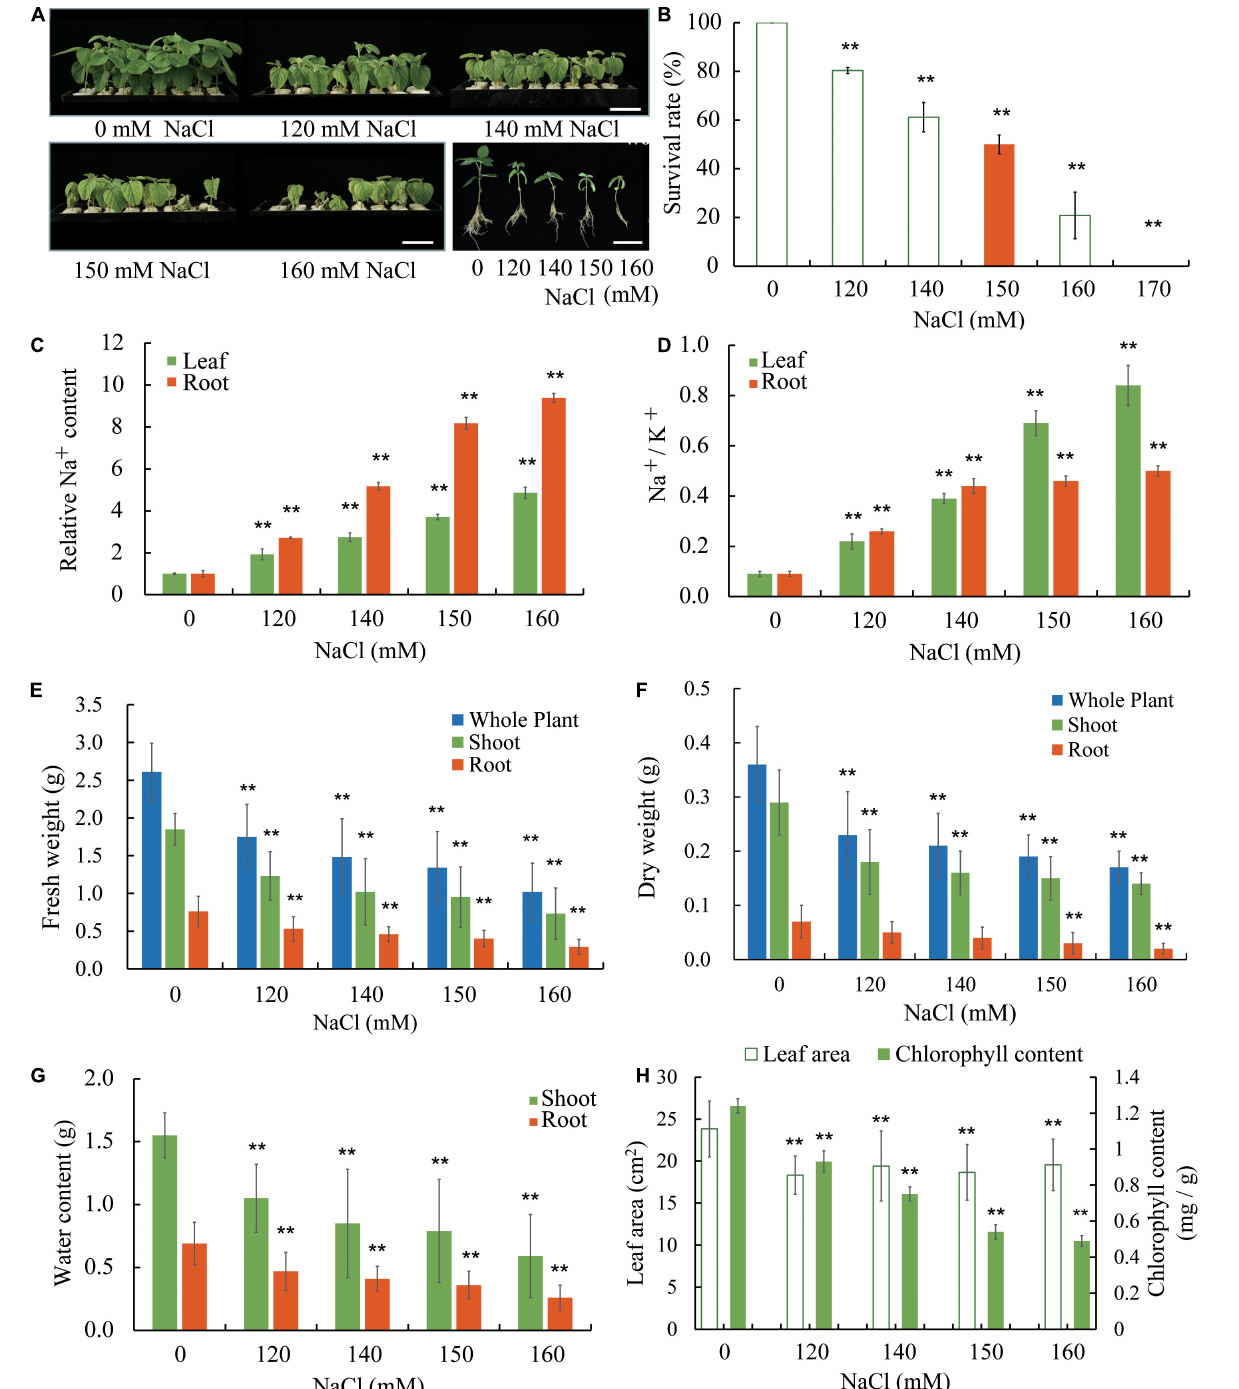
Frontiers in Plant Science |